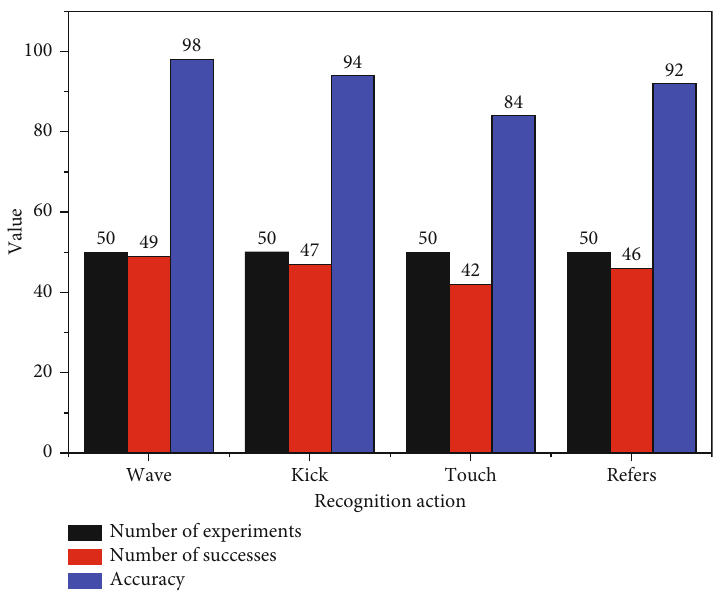
Figure 6: Experimental results of motion recognition accuracy.